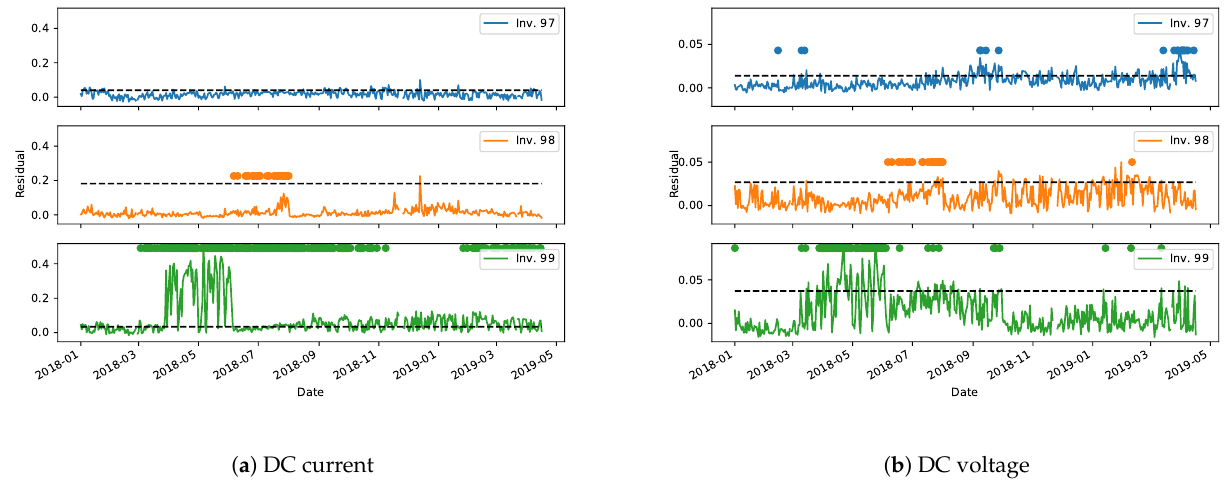
Figure 17. Control charts for anomaly detection on selected inverters from plant B. The dashed horizontal lines are the control chart limits, while the circles are the points in which the clustering algorithms detects an